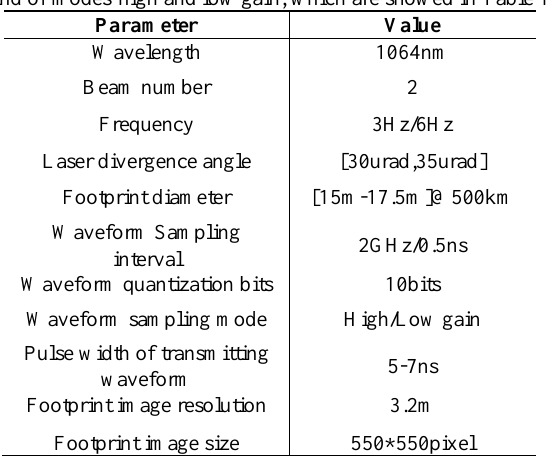
Table. 1 Parameters of GF-7 satellite laser altimeter